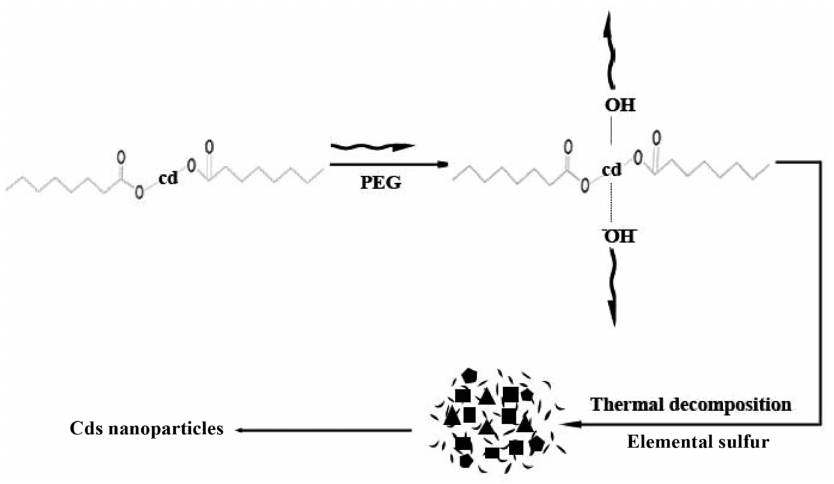
Scheme 1: Schematic of CdS nanoparticles